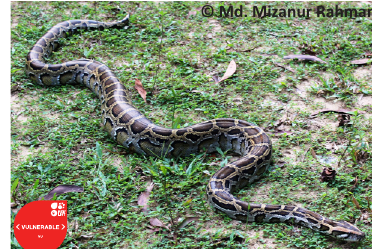
Image 1. Typhlops jerdoni Jerdon’s Blind Snake